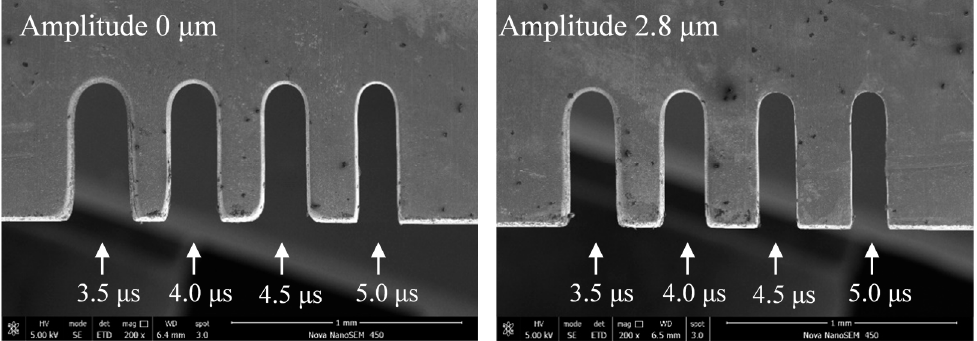
Figure 15. Variations in the slit width in relation to pulse period.